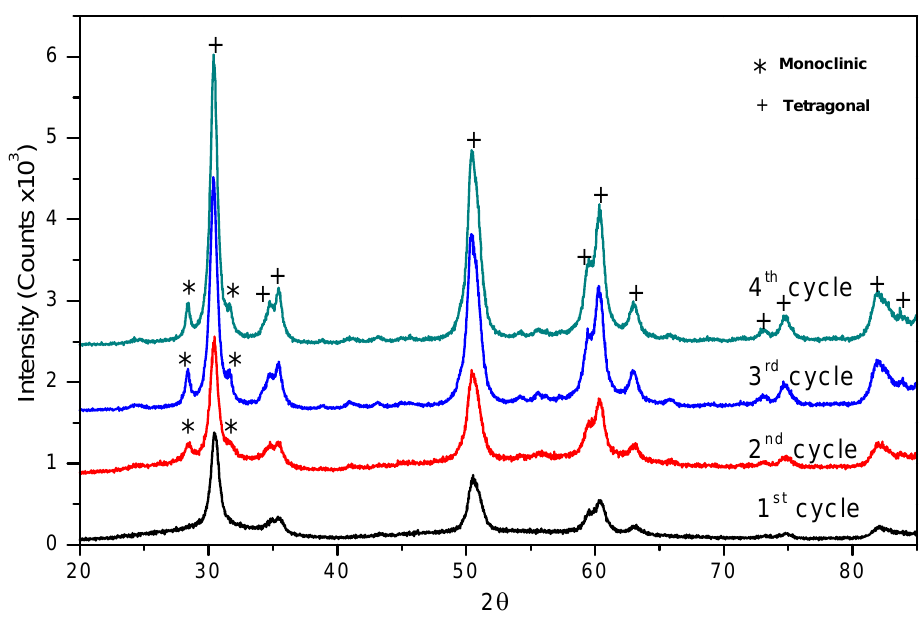
Figure 3. XRD Patterns of reactivated sulphated zirconia.